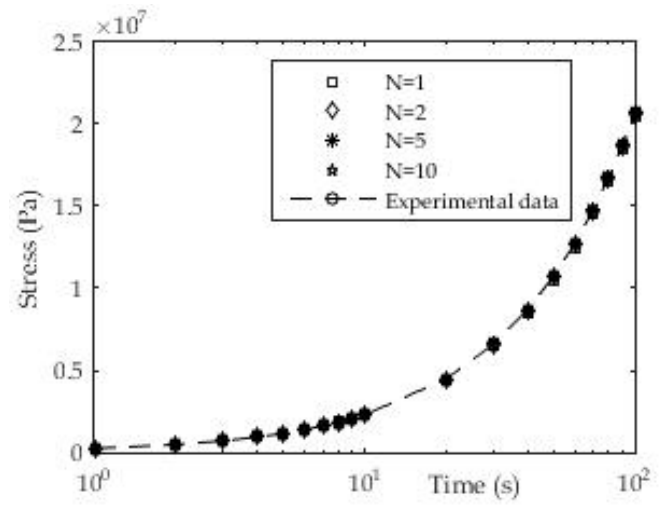
Figure 11. Experimental and fitted values of stress (ABS, d = 0.19 mm).